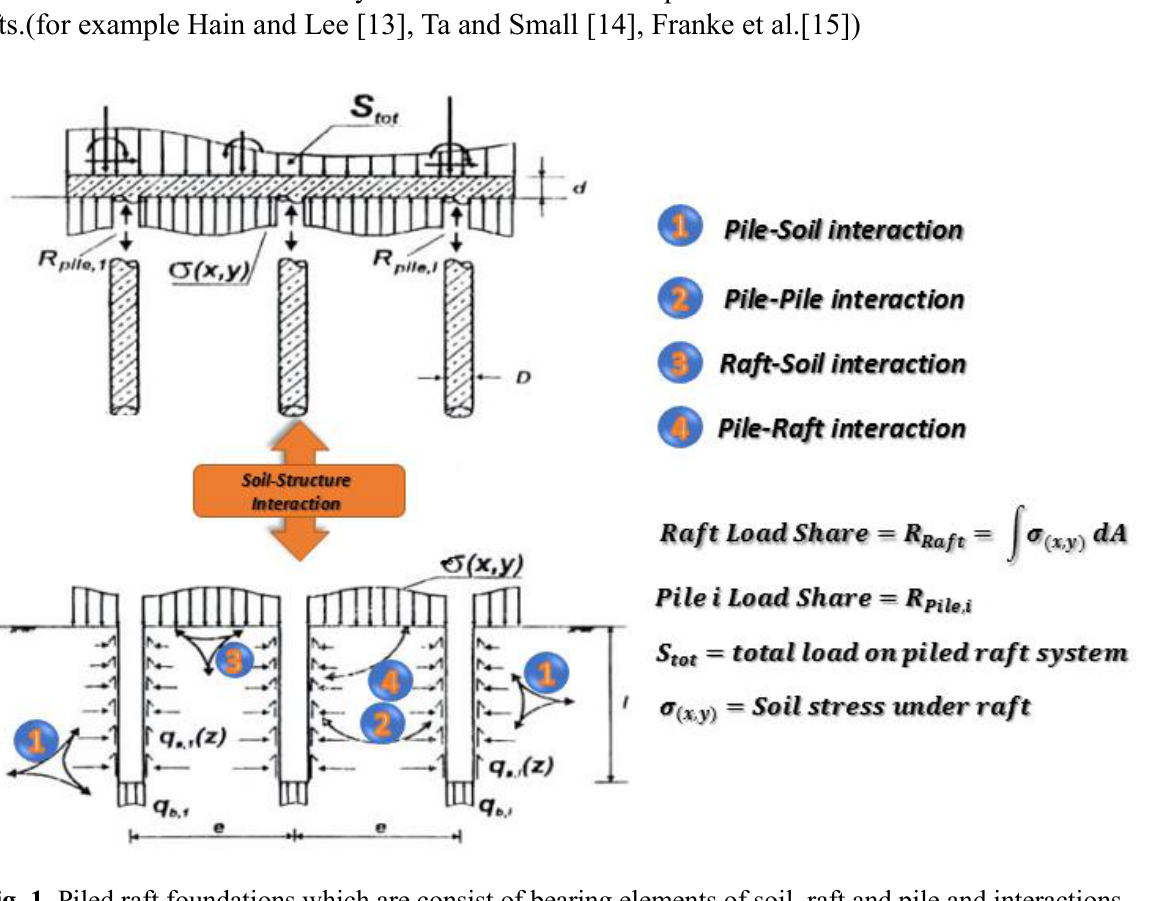
Fig. 1. Piled raft foundations which are consist of bearing elements of soil, raft and pile and interactions between these elements